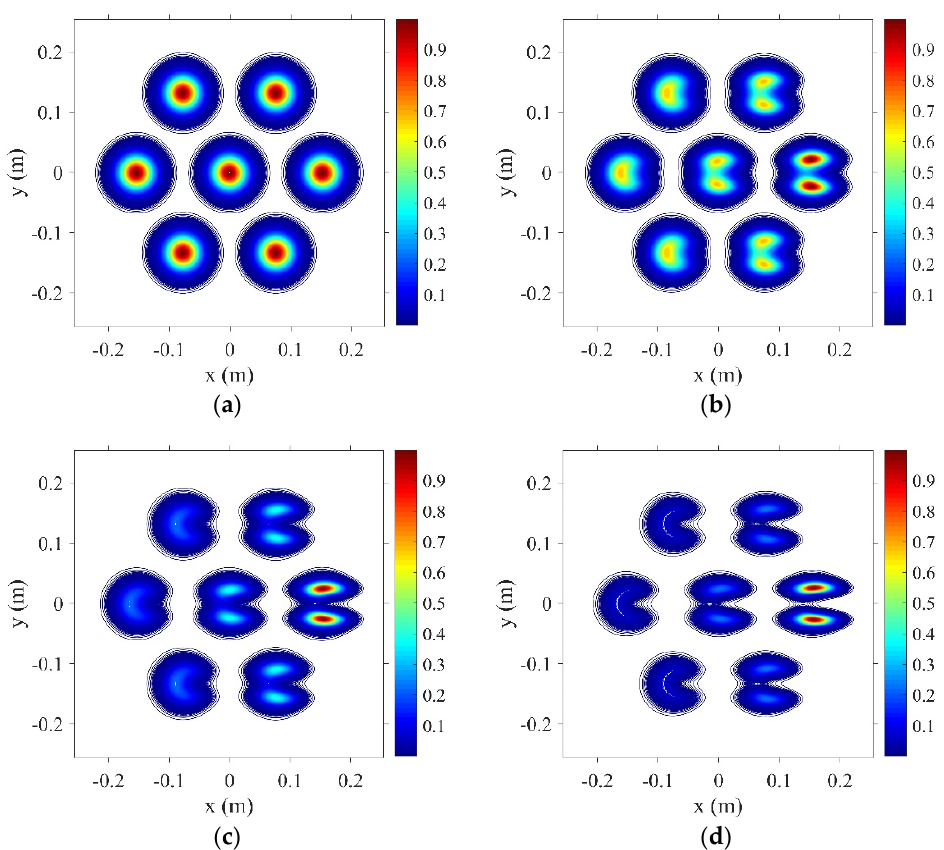
Figure 3. Thermal blooming of 7 − channel incoherent beams with ( a ) Initial arrangement; ( b ) N c = 0.5; ( c ) N c = 1.0 and ( d ) N c = 1.5.